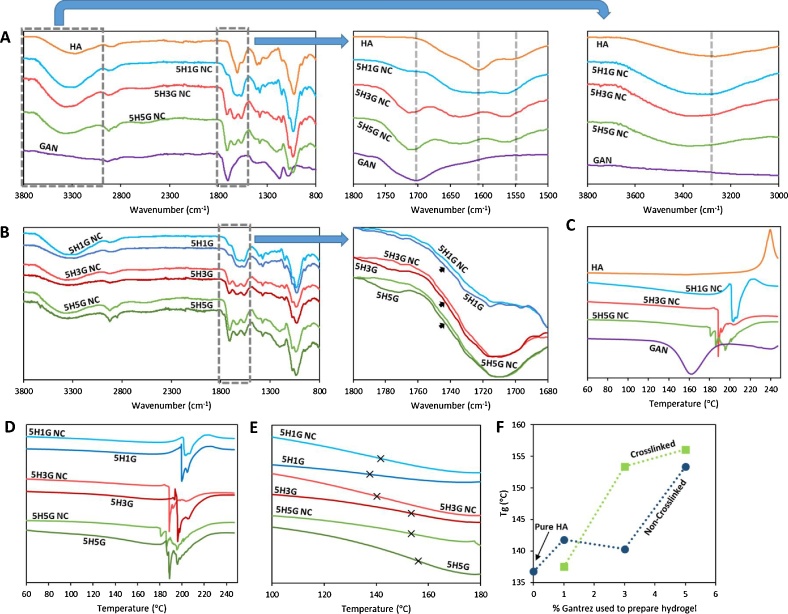
FTIR spectra of HA, GAN and HA/GAN mixtures before crosslinking (A). FTIR spectra of HA/GAN hydrogels before and after crosslinking (B). Magnified areas of the original spectra can be seen on the right hand in each case. DSC thermograms of HA, GAN and HA/GAN mixtures before crosslinking (C). DSC thermograms of HA/GAN hydrogels before and after crosslinking between: 60 and 250 °C (D) and 100 and 180 °C (E). The cross indicates the Tg value in the curves. Tg values as a function of the GAN% in the material (F). For all thermograms: Exo Up.